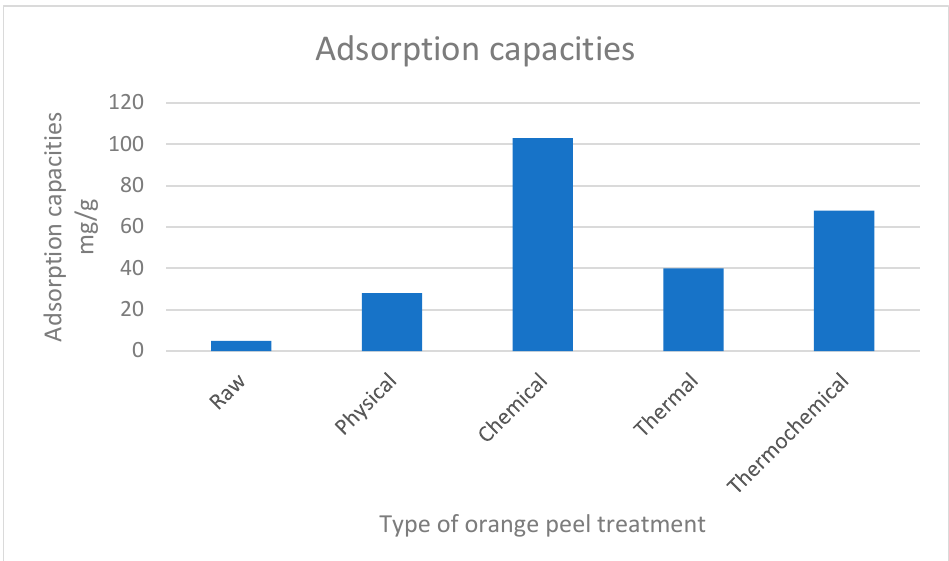
Figure 7. Adsorption capacities of modified orange peels.